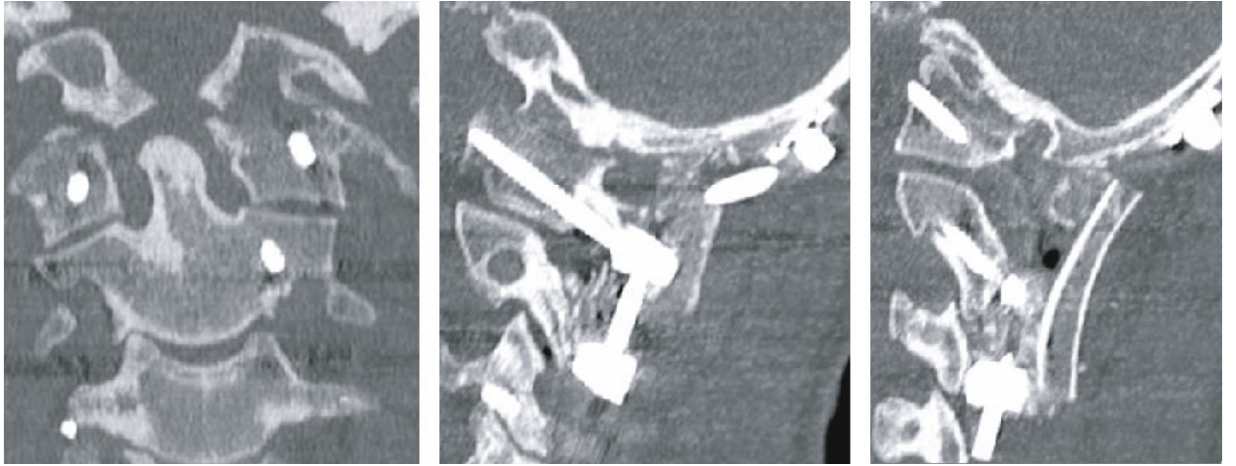
Figure 7: Case 2: CT postoperative. Anatomic alignment with reduction of the atlantooccipital fracture dislocation with bilateral C1, C2, and C3 lateral mass